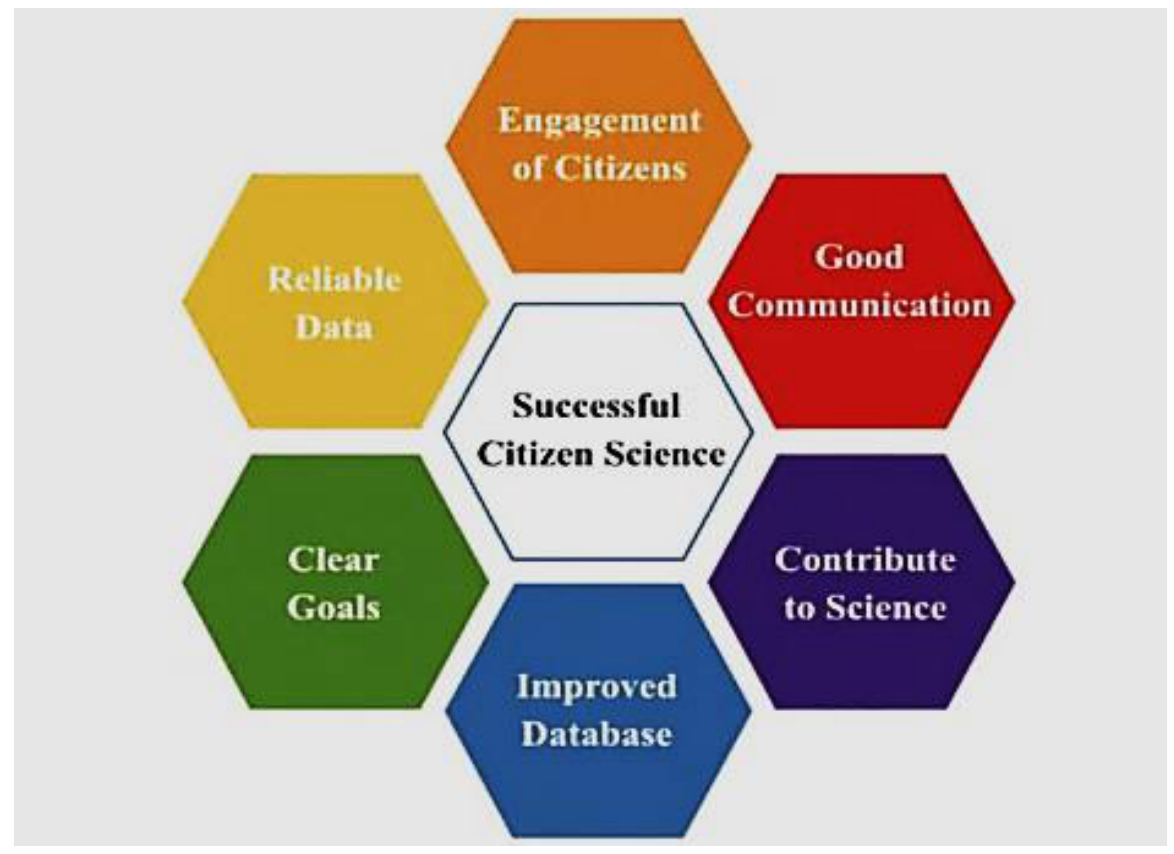
Figure 27. Successful citizen engagement.